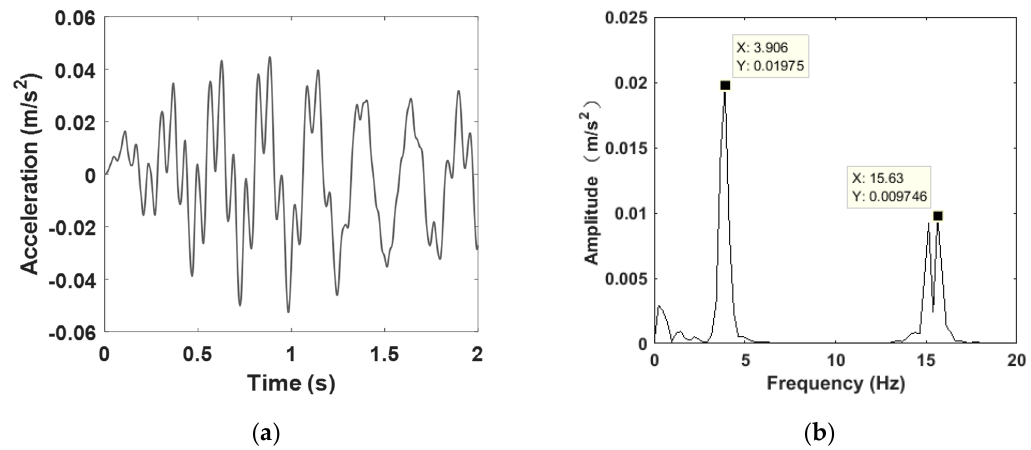
Figure 4. ( a ) The acceleration response measured on the vehicle and ( b ) the fast Fourier transformation (FFT) of the acceleration response.